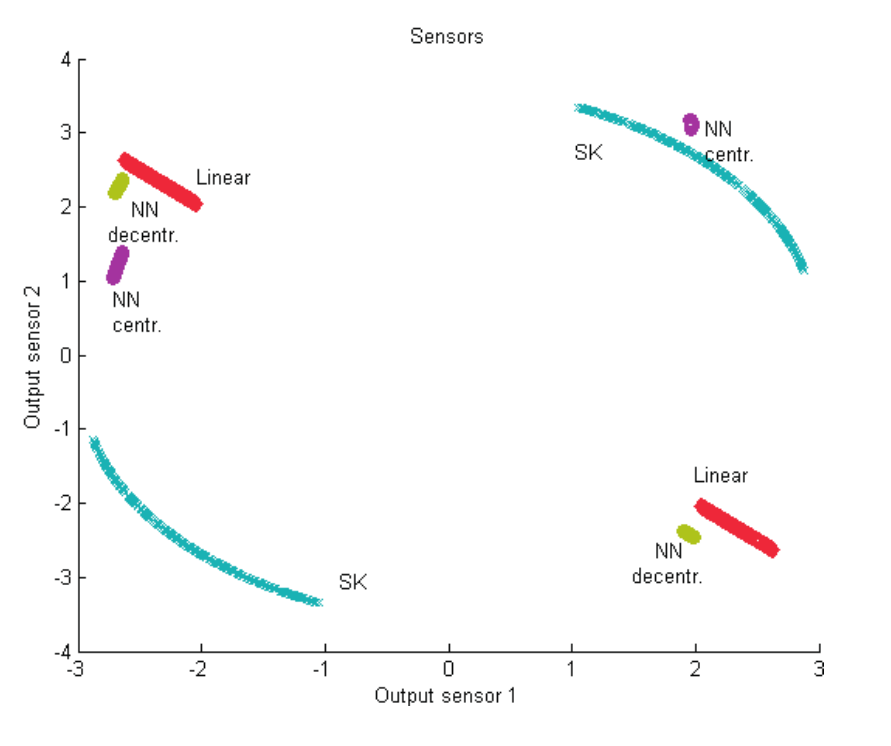
Figure 2. Single source with bimodal distribution: coders.